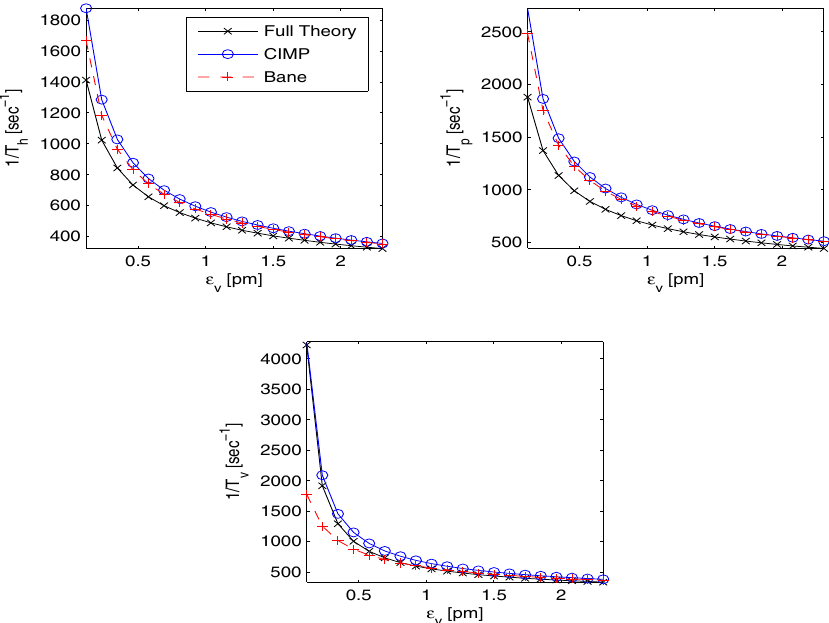
FIG. 4. (Color) IBS growth rates vs vertical emittance for the ATF prototype damping ring without betatron coupling.